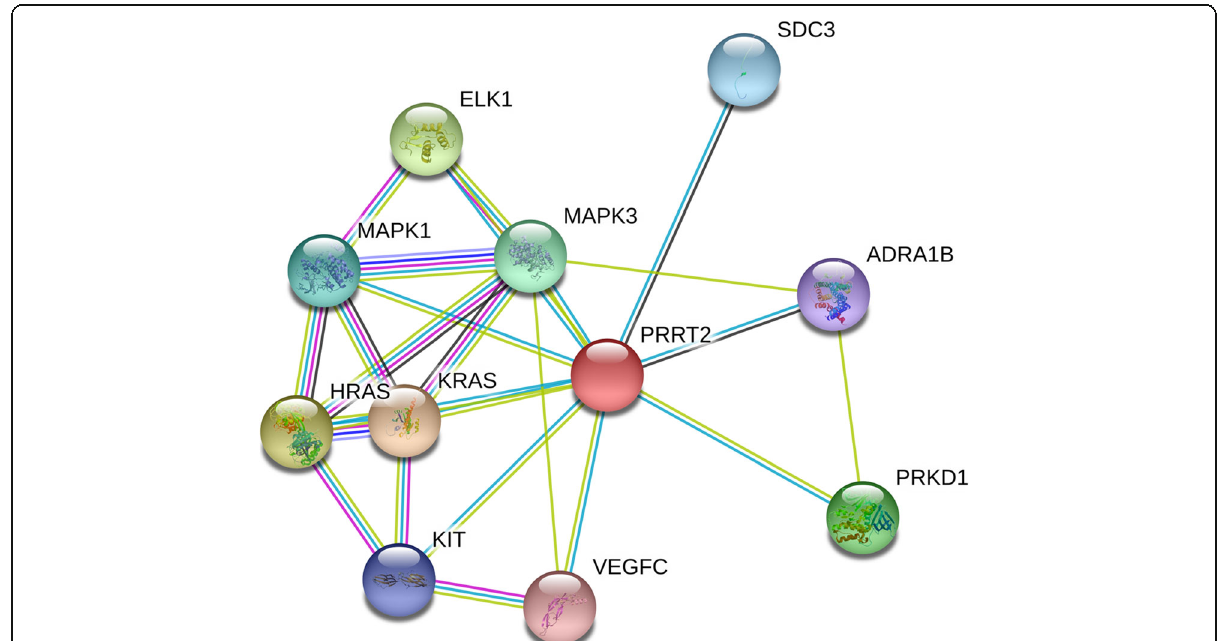
Fig. 10 Prediction of proteins interacted with human